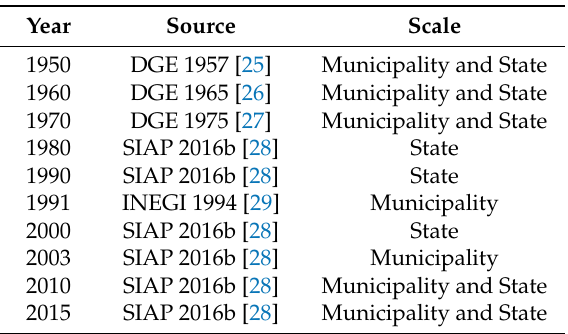
Table 1. Sources of data by year and